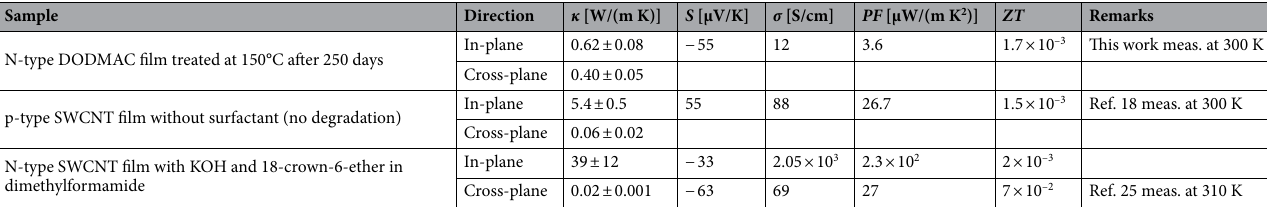
Table 1. Thermal transport properties of SWCNT films.